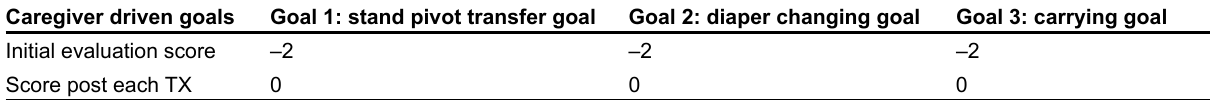
Table 4. GAS Caregiver driven goals Goal 1: stand pivot transfer goal Goal 2: diaper changing goal